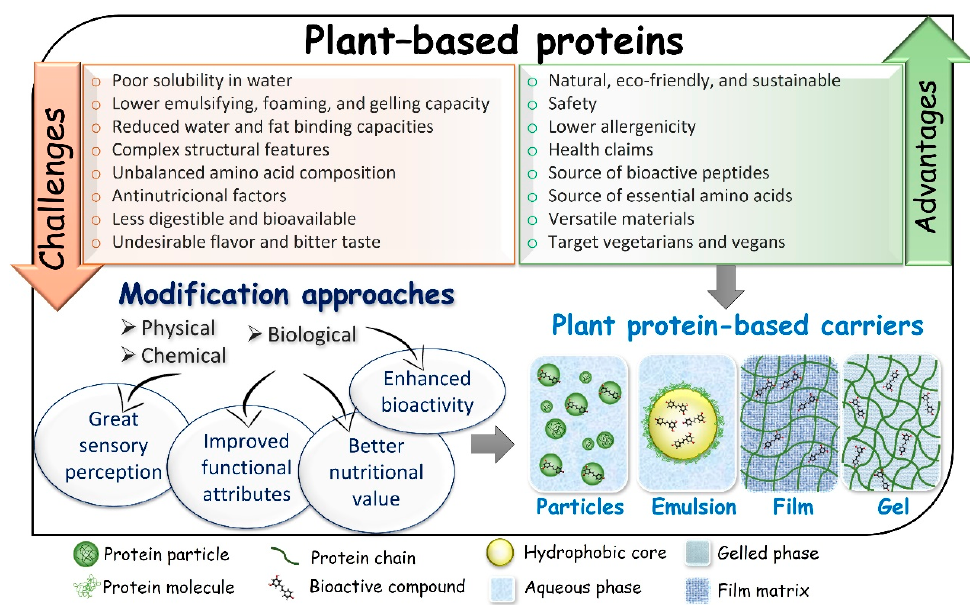
Figure 2. Plant-based proteins: Advantages, challenges, and modification methods aiming at produc- ing different carrier systems for lipophilic bioactive